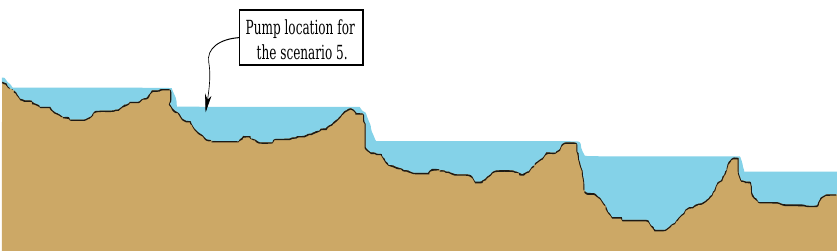
Figure 13. Ponds configuration in the river. Image designed with Inkscape.